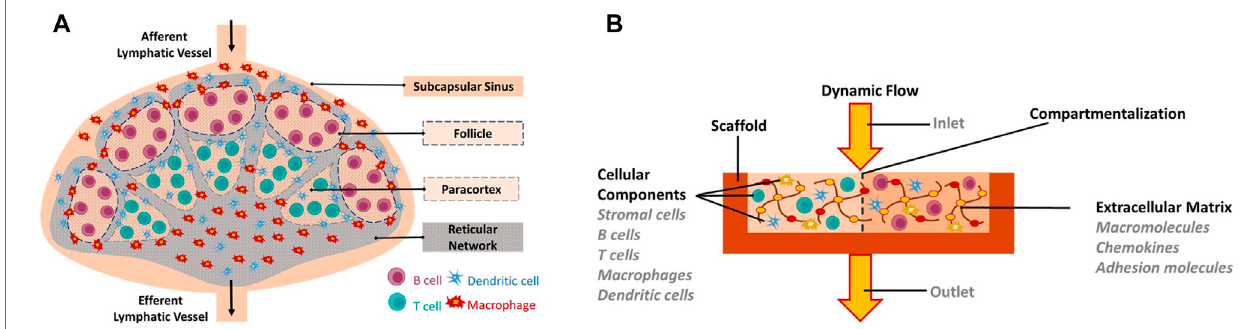
FIGURE 1 | In vitro engineering of human Lymph node-on-a-Chip. (A) Schematic of the human native lymph node. (B) Requirements for in vitro biomimetic lymph node-on-chip. Requirements include: Biomimetic scaffold on which cells can be seeded or grown, cellular components (immune cells and stromal cells), appropriate extracellular matrix components, dynamic fl ow conditions, key features of the native lymph node including compartmentalization.